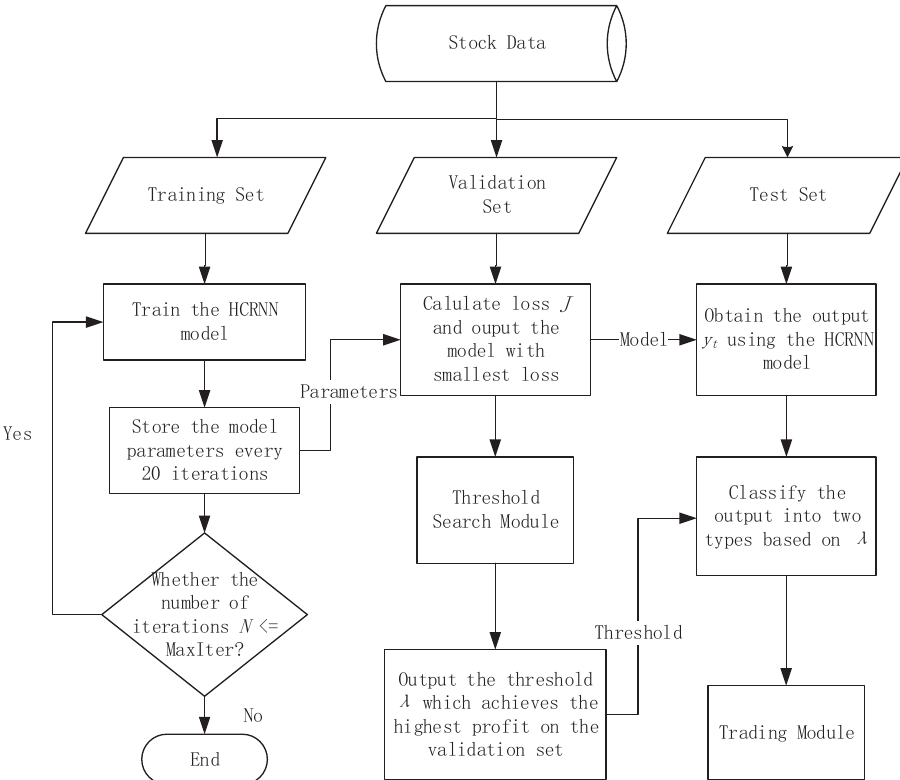
Figure 5. The flow chart of the proposed important trading point prediction framework based on a hybrid convolutional recurrent neural network